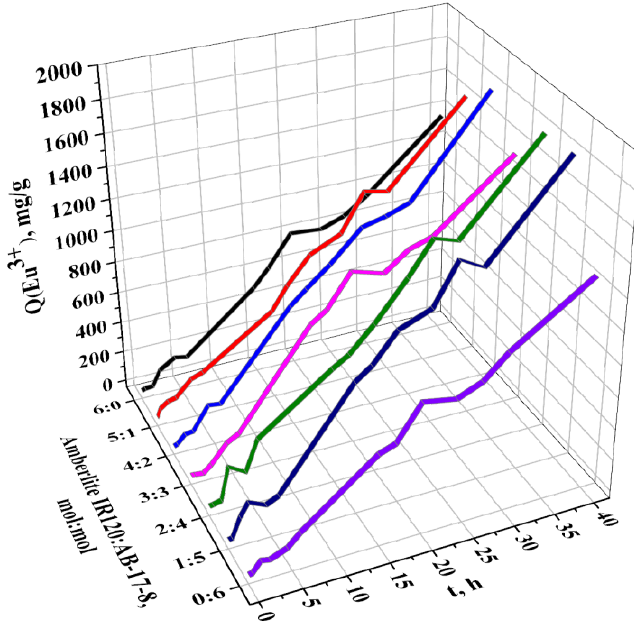
Figure 7. Effective dynamic exchange capacity in dependence from molar ratios and